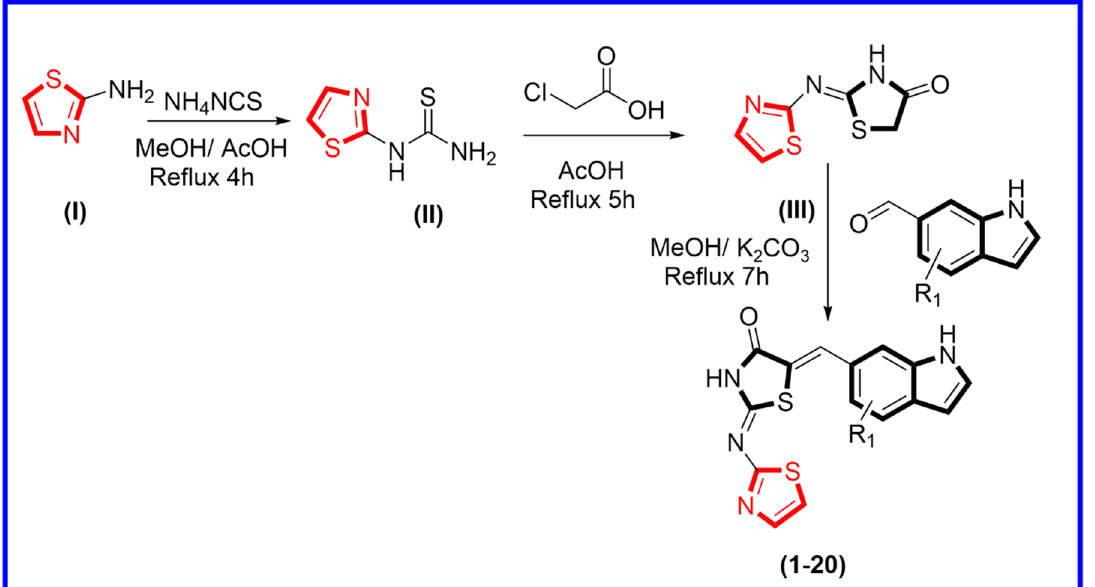
Table 1. Substituted thiazolidinone-based indole derivatives along with biological profile ( 1–20